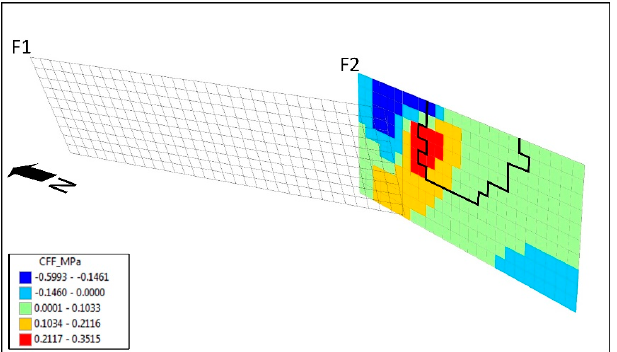
Figure 7. Coulomb stress changes caused from F1 onto the receiver fault F2. The black-noted polygon on F2 denotes the extent of the source’s slip distribution. InSAR cannot o ff er information on the deformation at the areas that are covered by water